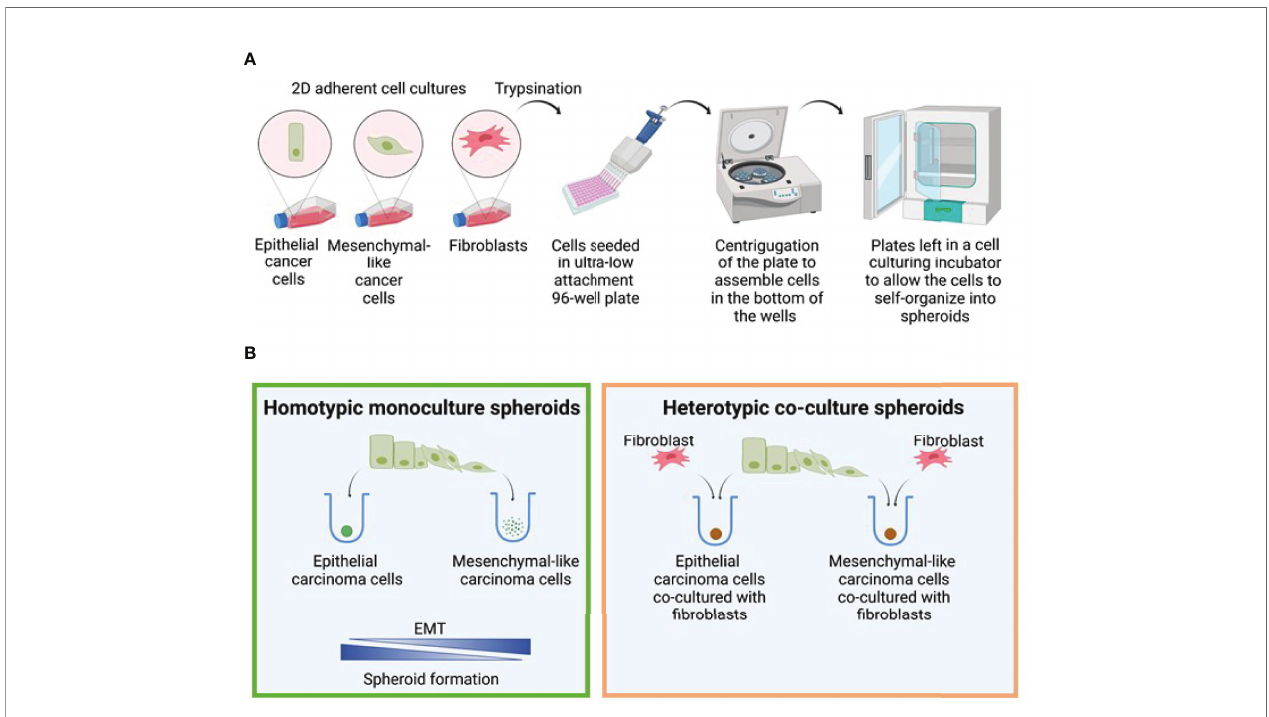
FIGURE 2 | Spheroid formation model. (A) Model fi gure depicting the generation of 3D monoculture spheroids in round bottom ultra-low attachment plates. (B) The ef fi ciency of spheroid formation is closely linked to the degree of EMT, and the epithelial cells generated spheroids in monoculture much more ef fi ciently than the mesenchymal cells. In contrast, both epithelial and mesenchymal phenotypes were able to form spheroids when co-cultured with fi broblasts. Figure created with